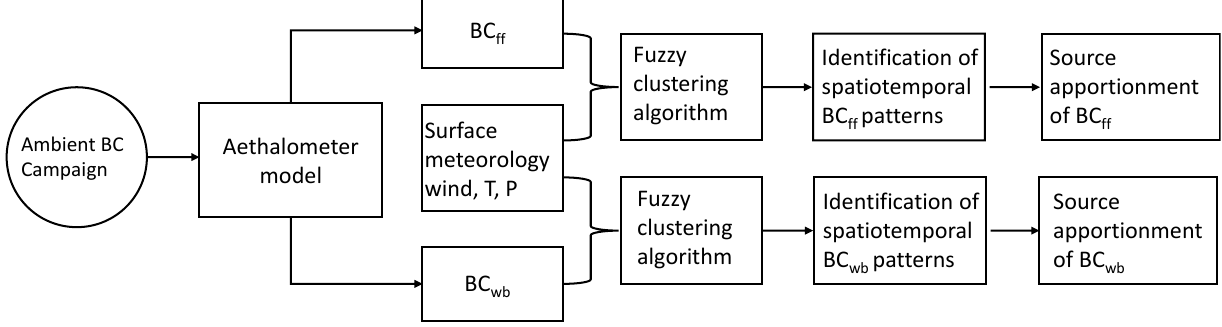
Figure 1. Workflow of the methodology.